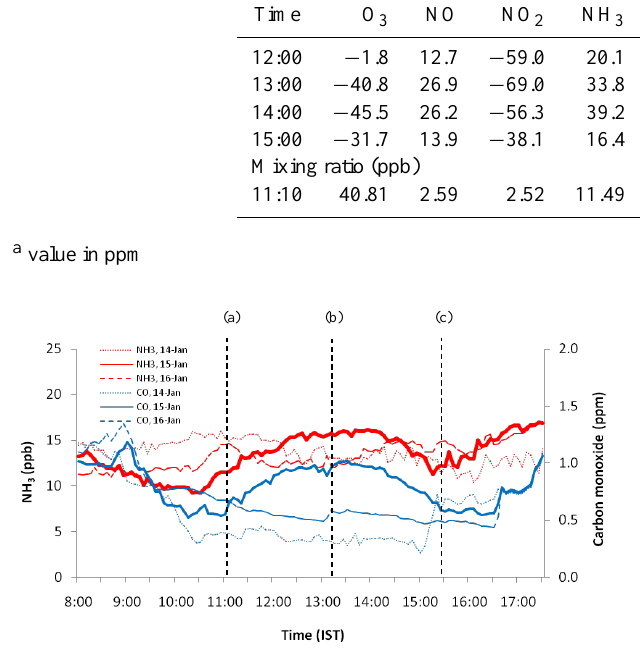
556 Fig. 3. Ambient NH 3 and CO measured before, during and after Figure 3: Ambient NH 3 and CO measured before, during and after the total solar eclipse 557 occurred on 15 January, 2010 at Thiruvananthapuram, India, (a) beginning of the 558 the total solar eclipse occurred on 15 January, 2010 at Thiruvanan- solar eclipse, (b) solar eclipse maximum, (c) end of the solar eclipse a day before and 559 a day after of the solar eclipse. 560 thapuram, India, (a) beginning of the solar eclipse, (b) solar eclipse 561 maximum, (c) end of the solar eclipse along with a day before and a day after of the solar